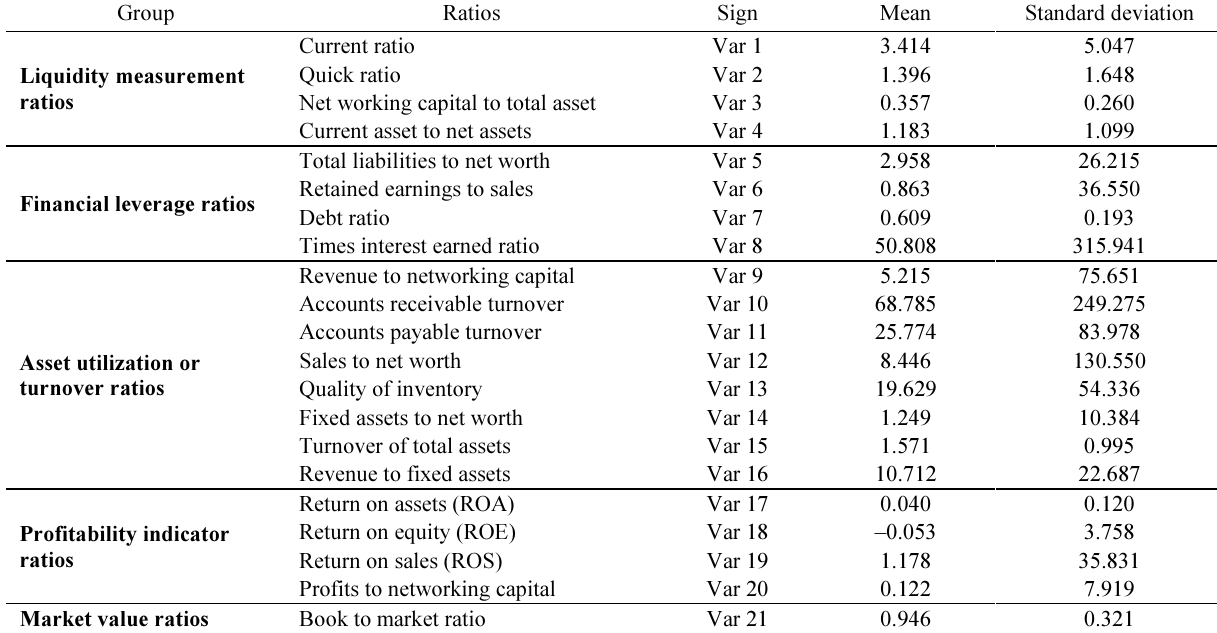
Table 2. Statistical characteristics of the selected financial ratios